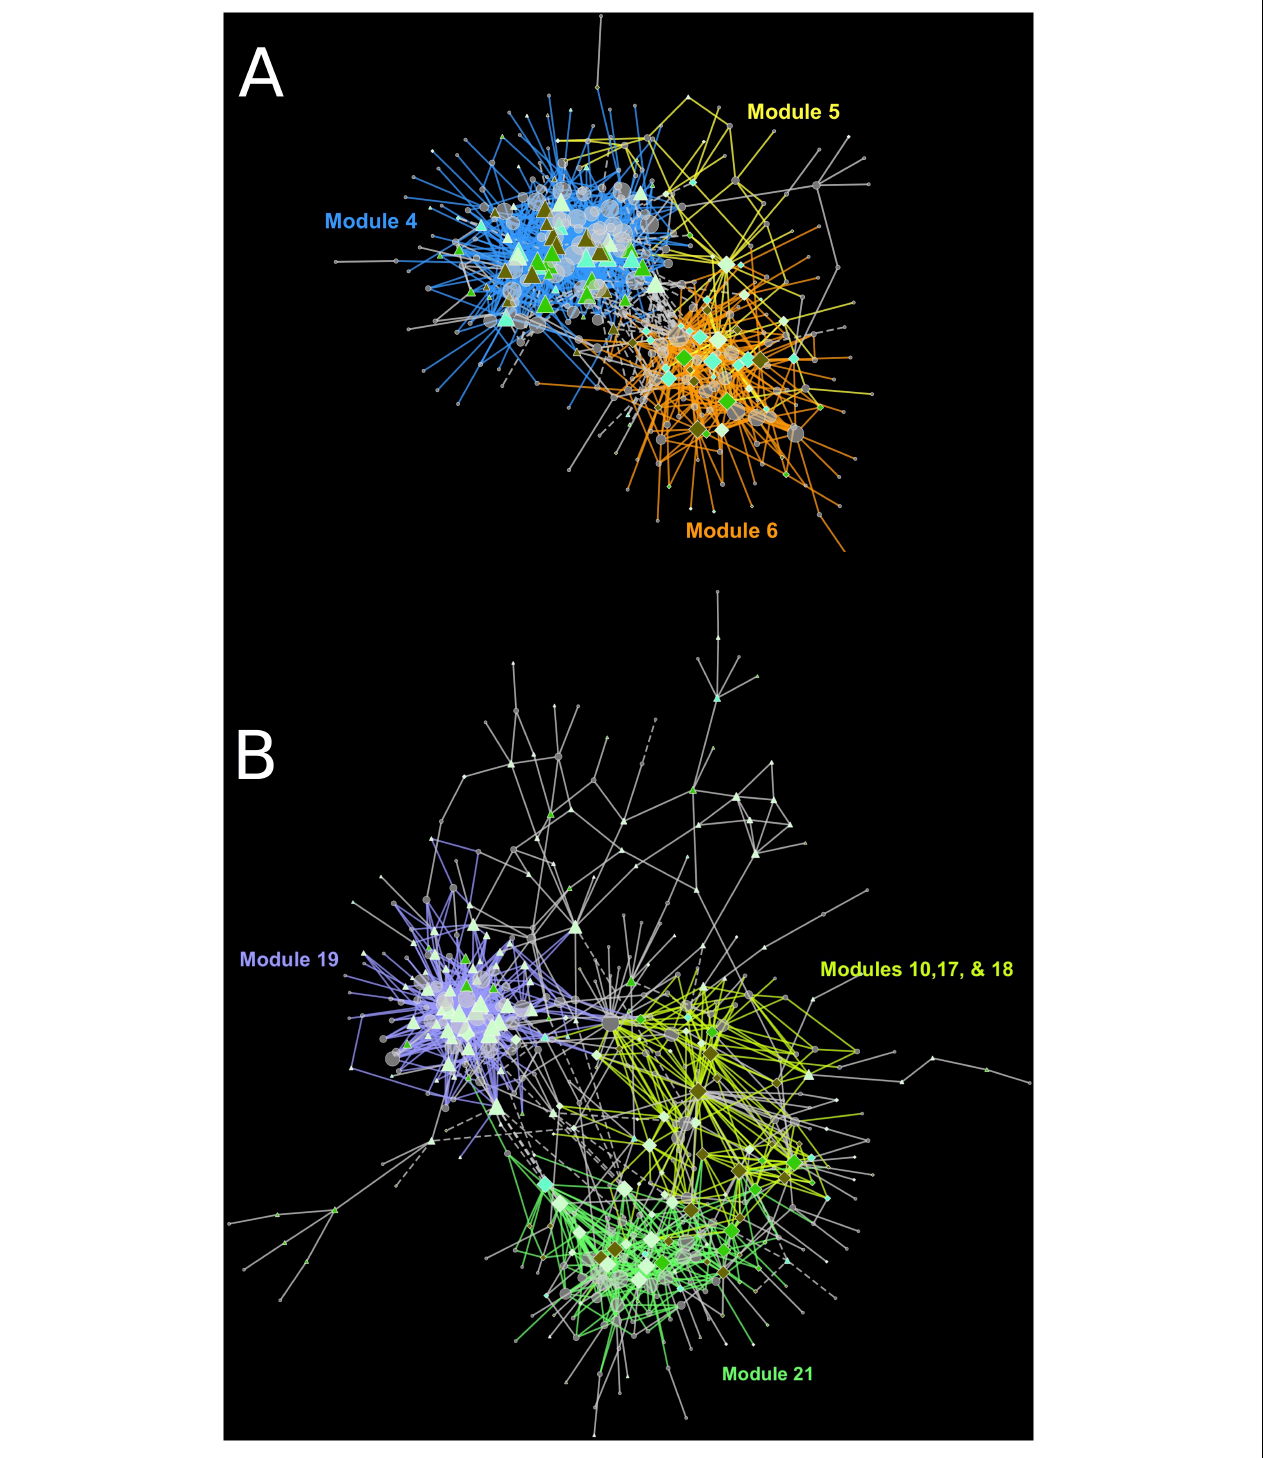
FIGURE 6 | Tissue-specific, position-phased, csGCNs colored by modules and containing differentially up or down regulated genes. (A) cortex phased co-expression network, (B) peel phased co-expression network. Triangles indicate upregulation in external canopy positions, diamonds indicate downregulation. Node color intensity indicates DE at different timepoints with darker colors showing differential expression at later timepoints. Significant differential expression was determined by Bonferroni P < 0.05. Colored edges and matching labels indicate major modules. Gray edges indicate minor modules with a small number of edges. See Supplementary File 3 for network